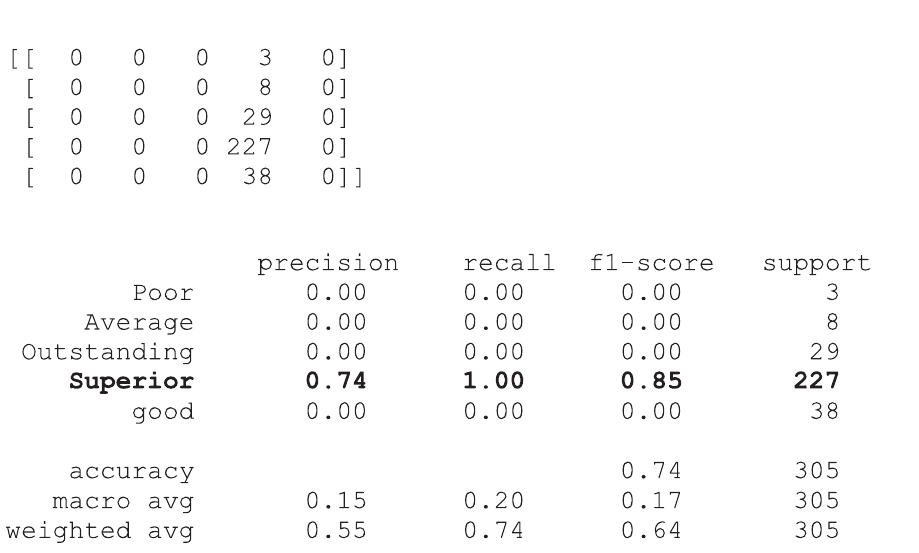
Figure 19: Deep learning confusion matrix and accuracy